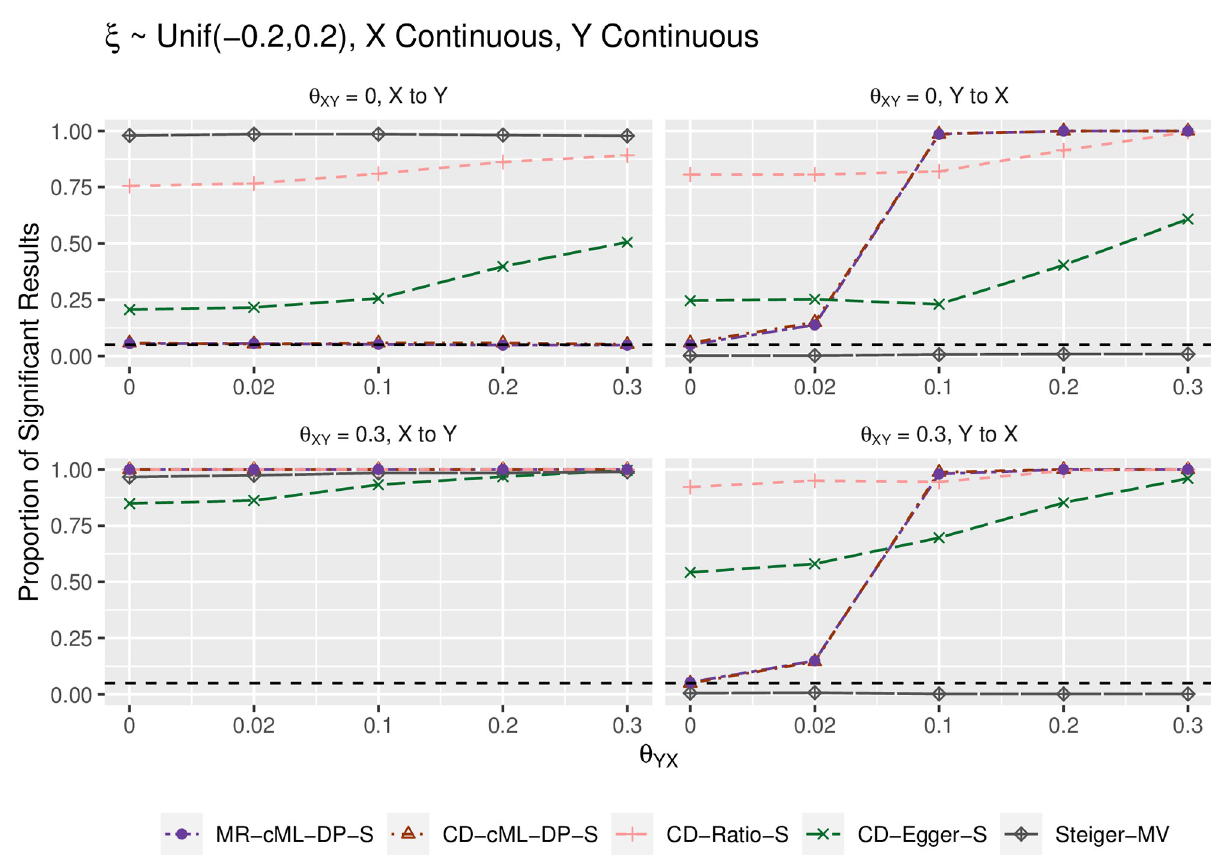
Fig 4. Empirical type-I error and power (y-axis) for both X and Y continuous, ξ from a uniform distribution (i.e. with correlated pleiotropy, implying InSIDE violated), θ = 0 (top panels) and θ = 0.3 (bottom) for various values of θ XY XY direction X ! Y , the right ones show results for the direction Y ! X .